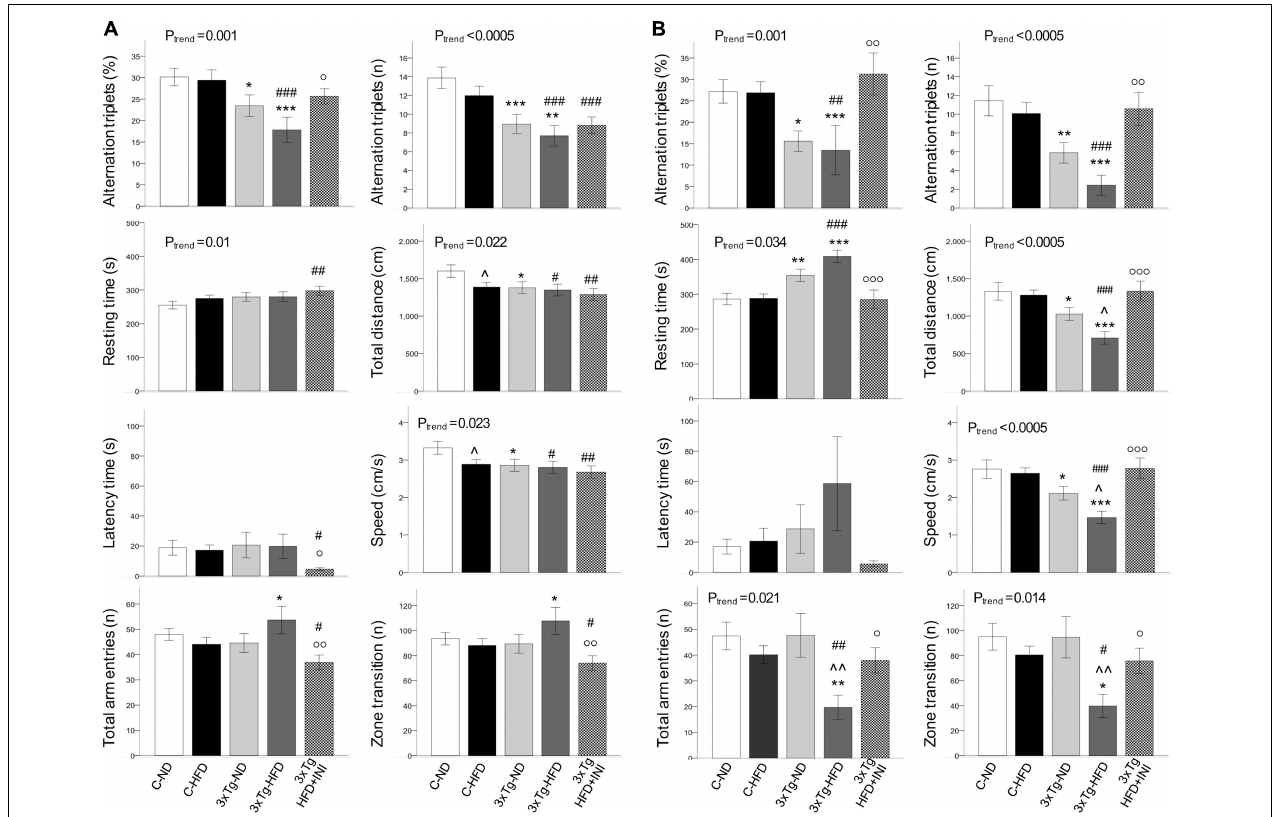
FIGURE 5 | Cognitive function parameters at the age of 8 (A) and 14 months (B) . Data are presented as mean ± SEM. Sample sizes are given in Table 1 . P trend refers to regression analyses across the first four groups. ∗ p < 0.05 or less ( ∗∗ , ∗∗∗ ) ND-ND and HFD-HFD (between strains), ∧ p < 0.05 or less ( ∧∧ ) HFD vs. ND (within-strain), # p < 0.05 or less ( ## , ### ) vs. ND control group (reference group), ◦ p < 0.05 or less ( ◦◦ , ◦◦◦ ) for treated 3 × Tg-HFD + INI vs. untreated 3 ×